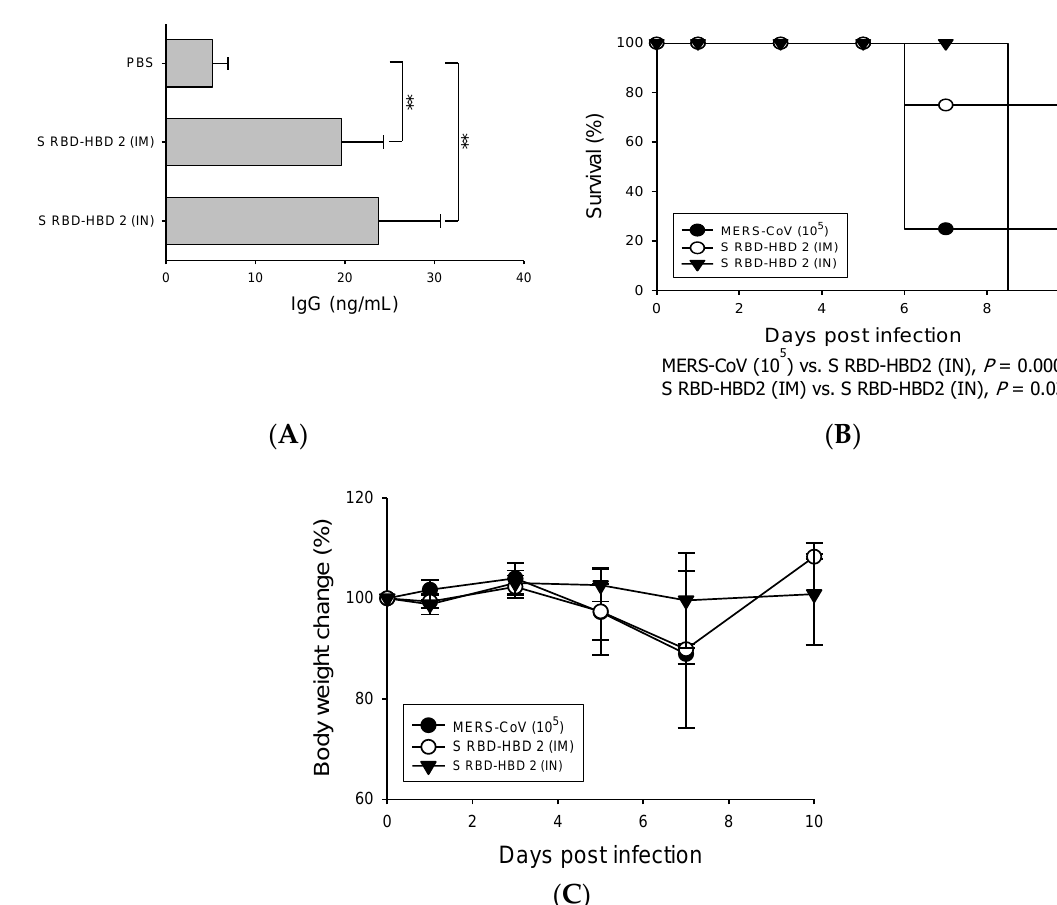
Figure 3. Intranasal immunization with S RBD-HBD 2 provides superior immunogenicity and protection against MERS-CoV in hDPP4-Tg mice. Mice were immunized with 5 µg/mouse of S RBD-HBD 2 intramuscularly (IM) or 1 µg/mouse intranasally (IN), and sera were collected three days after the last boost immunization. The levels of the S RBD-specific IgG were measured using ELISA. Data are presented as means ± SDs ( n = 3). Immunized mice were challenged intranasally with MERS-CoV (10 5 PFU) and monitored every other day for weight loss, clinical symptoms, and survival. ( A ) Serum levels of S RBD-specific IgG which were determined via capture ELISA using standard mouse IgG. ** p < 0.01. ( B ) Survival of hDPP4-Tg mice after MERS-CoV infection ( n = 8). P -values were calculated using the log-rank (Mantel – Cox) test. ( C ) Body weight changes in MERS-CoV-infected mice. Results are presented as means ± SDs ( n = 8) at the indicated times post-infection.